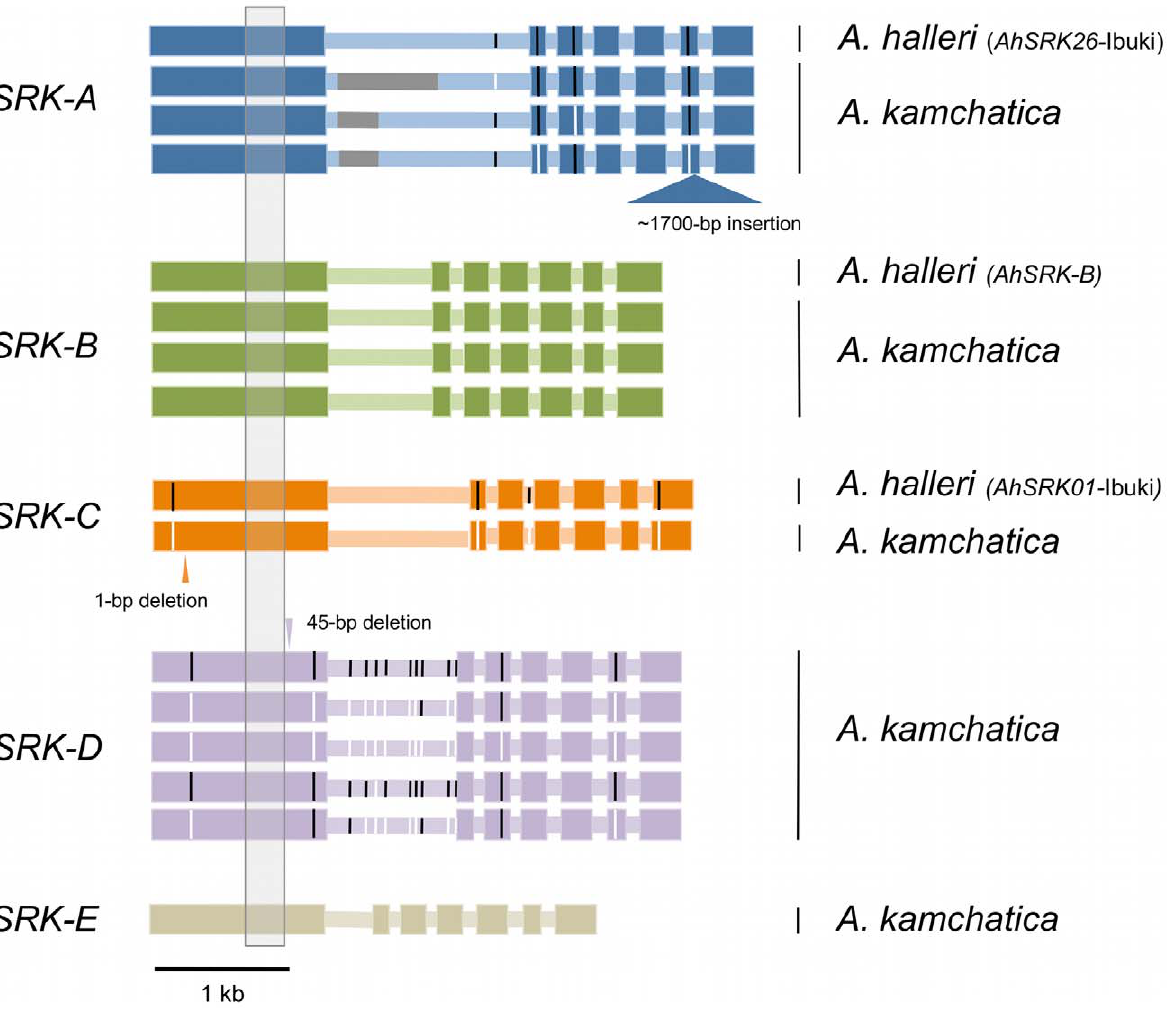
Figure 5. Entire coding sequences of SRK of five S -haplogroups from A.kamchatica and three S -haplogroups from A.halleri . Thick and thin horizontal bars indicate exons and introns, respectively. Black and white vertical bars indicate single nucleotide polymorphisms found in each haplogroup. Nucleotide sequences were not available for part of the first intron of SRK-A because of repetitive sequences (indicated by gray bars). The gray shaded region in exon 1 was used for generating the phylogenetic tree in Figure 1.